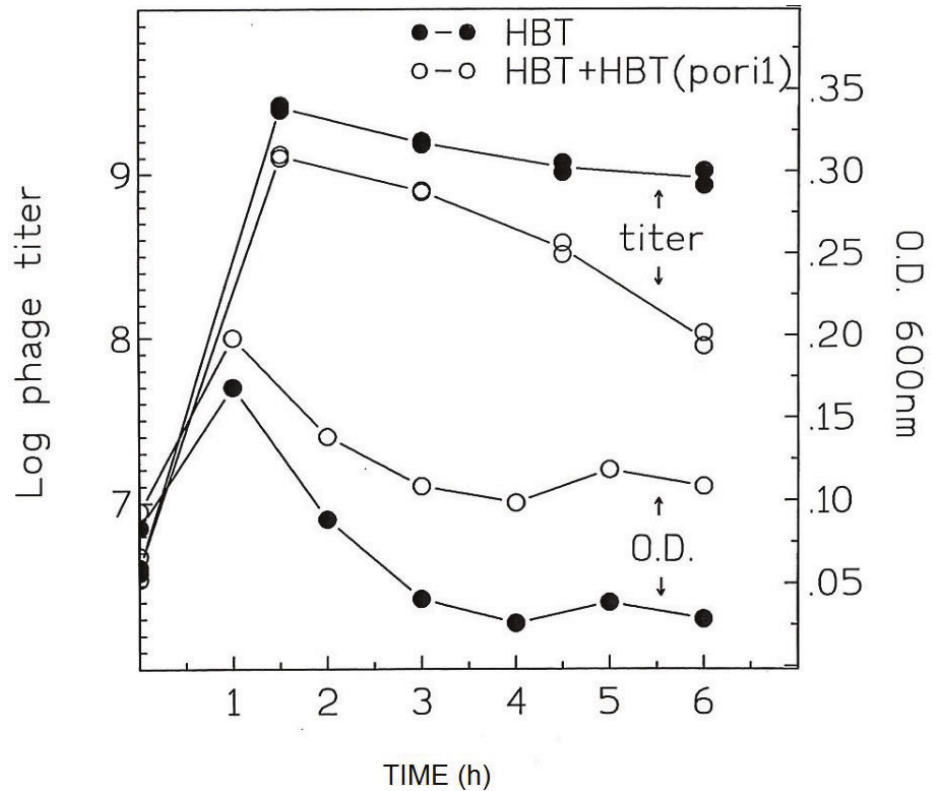
Figure 6. Effect of addition of uninfected HBT(pOri1) culture to a λ -infected HBT, on bacterial growth and phage titer. A culture of λ -infected HBT was either left alone (HBT) or supplemented with a 1/100 volume of uninfected HBT(pOri). Both the turbidity of the cultures, and the phage titers, were determined at the indicated times after infection (phage titers are expressed in a log